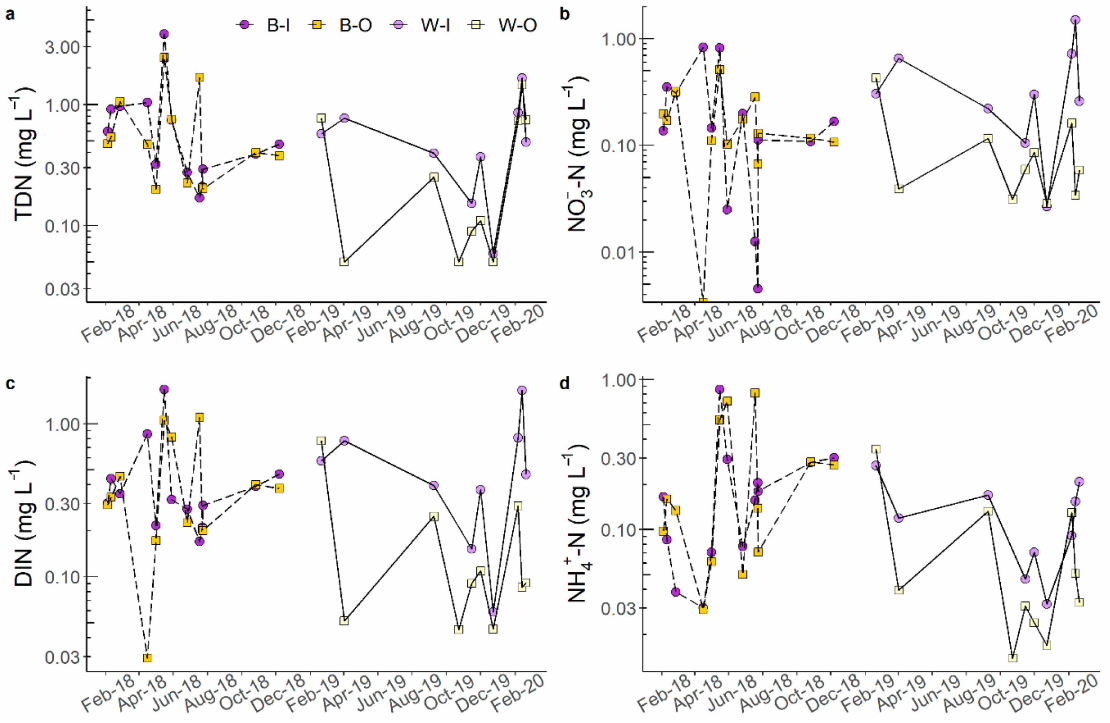
Figure 6. Line plots of flow-weighted concentrations of total dissolved nitrogen (TDN) ( a ), nitrate (NO 3 − N) ( b ), dissolved inorganic nitrogen (DIN) ( c ), and ammonium (NH 4 + N) ( d ), at the inlet (I) and outlet (O) of the dry basin (B) and wetland